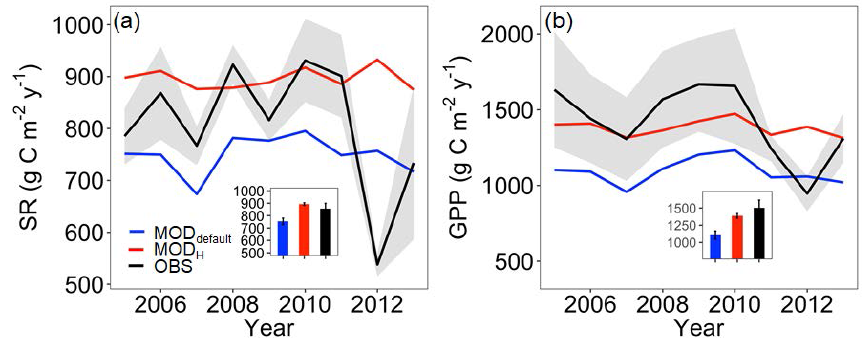
Figure 2. Annual SR and GPP. Blue and red lines are model outputs before (MOD default ) and after (MOD H ) soil water potential improvement, respectively. Black lines and grey area are the observed (OBS) mean and 1 σ (i.e., standard deviation) range, which were calculated from eight field replications for SR, and from three different net ecosystem exchange partitioning methods for GPP. The inserted bar plots are mean annual average ± 1 σ across 2005–2011. Table 2. Modified parameters to better simulate GPP and LAI at the MOFLUX site in